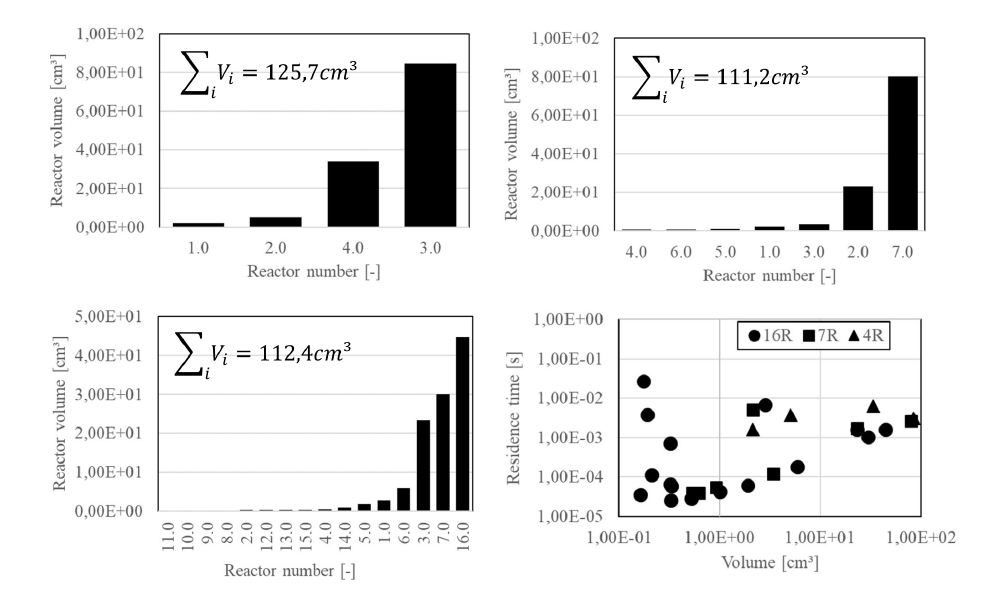
Figure 12. ERN volume distribution and comparison of residence time